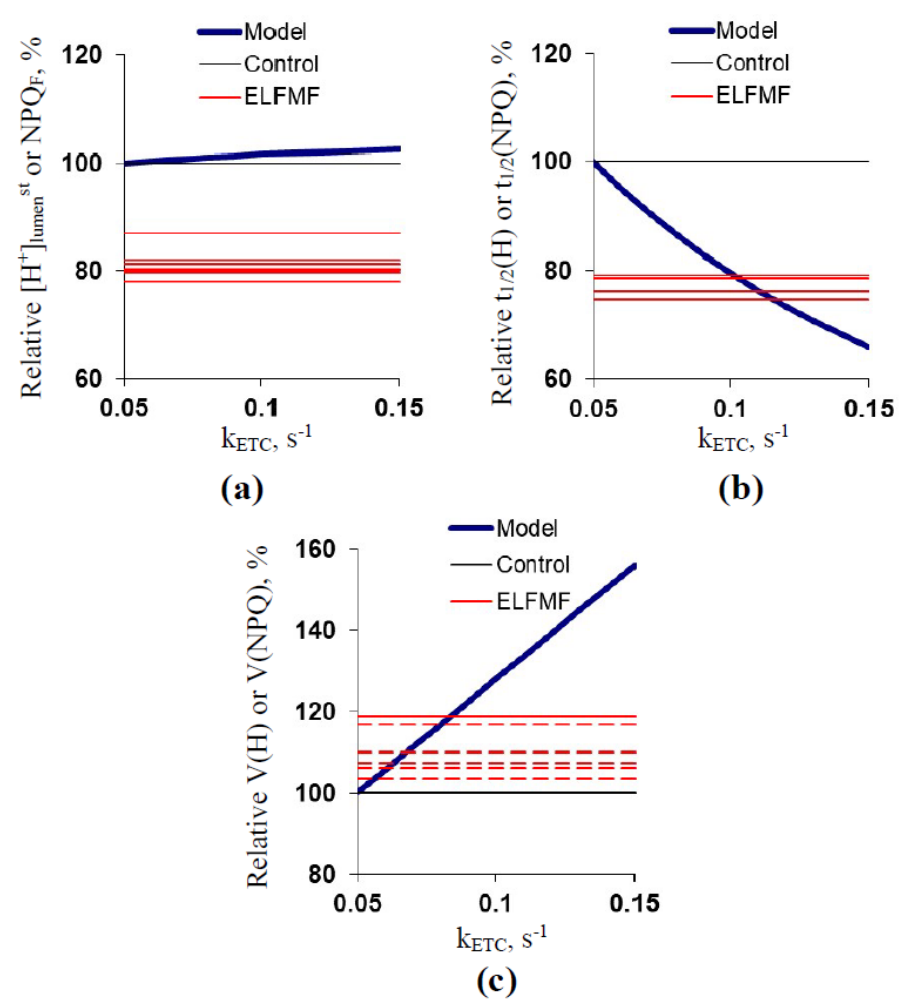
Figure 6. Dependencies of simulated stationary [H + ] lumen ([H + ] lumenst ) ( a ), t 1/2 (H) ( b ), and V(H) ( c ) on k ETC . Relative values were calculated as percentage from simulated values at k ETC = 0.05 s −1 , k S = 0.13 s −1 , and k L = 0 s −1 (see Figure 5b). Figure 6 also shows relative control and experimental averaged values of NPQ F ( a ), t 1/2 (NPQ) ( b ), and V(NPQ) ( c ); the experimental values include all variants of ELFMF treatments (with different ELFMF intensities). The results from Figures 2 and 3 were used. Relative values were calculated as a percentage from control values; standard errors were not included in Figure 6. Dotted lines show experimental parameters, which did not significantly differ from the